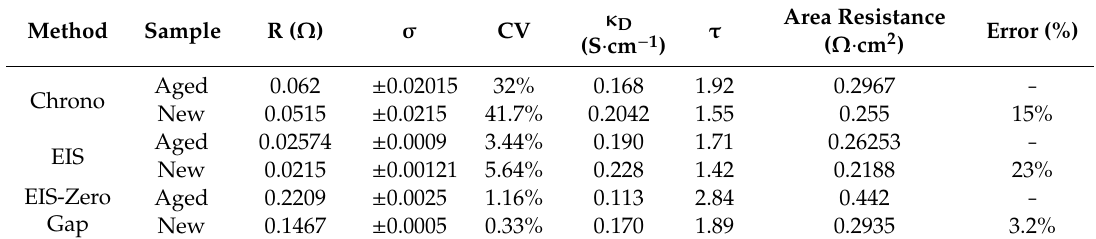
Table 2. Resistance and error values for new and aged diaphragm samples for accuracy and precision comparison of studied methods. Also, Ionic Conductivity, and Tortuosity values are